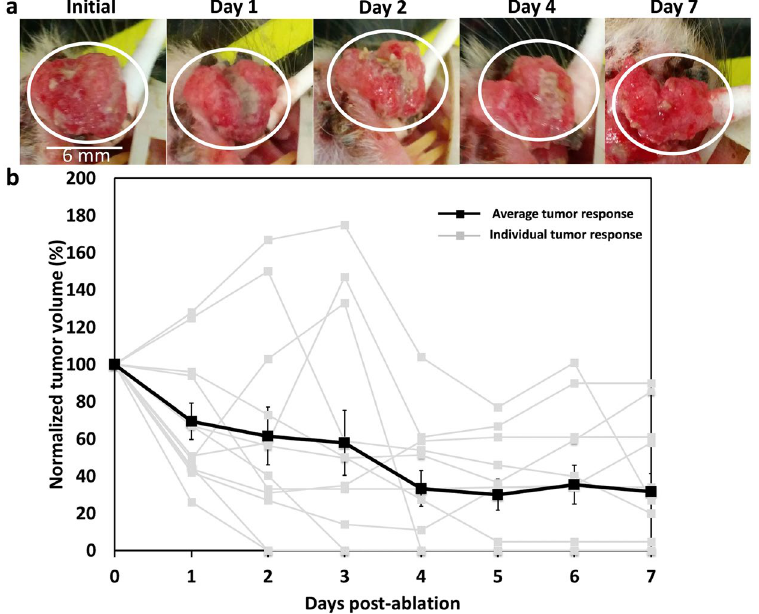
Figure 6. High-dosage manual ethanol ablation treatment of epithelial tumors is ineffective. ( a ) Representative images show typical tumor response over time, in which complete regression does not occur. Scale bar is approximately 6 mm. ( b ) 12 squamous cell carcinoma tumors were ablated and the tumor volume was measured over 7 days. At day 7, the average tumor volume was 32% of the initial volume and 4 out of 12 tumors had responded completely with no sign of a tumor. Therapeutic efficacy is quantified as normalized tumor volume, which is tumor volume as a percentage of its Day 0 value. Gray traces represent individual tumor responses and error bars depict standard errors of the